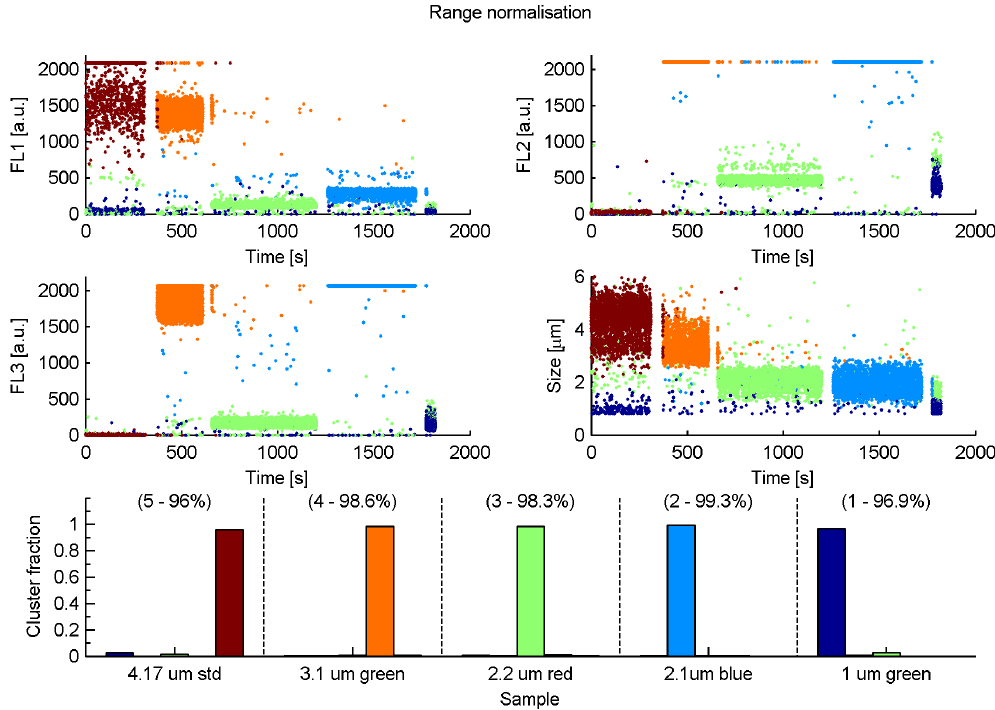
Figure 3. Time series of PSL samples with data points coloured by cluster assignment for Ward linkage and range normalisation. Bottom panel shows the fraction of each cluster assigned to each sample with the most populated cluster annotated